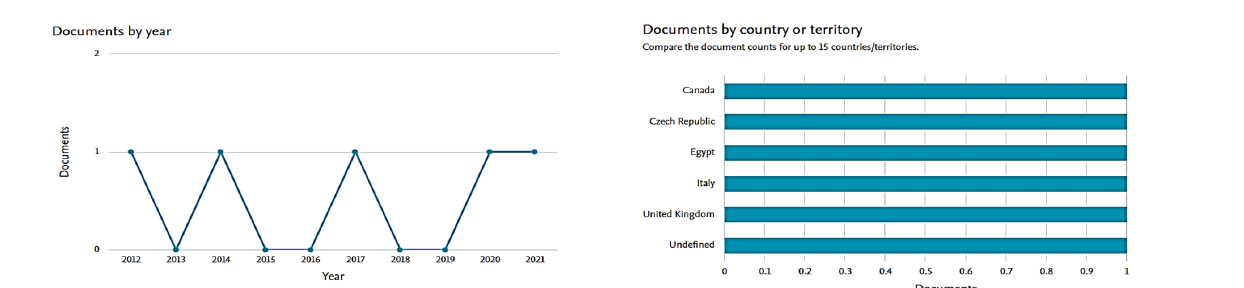
Fig. 7. Analysis and evolution of the words “hemp”, “ther- mal”, “insulating” and “brick” Source: Scopus scientific review.